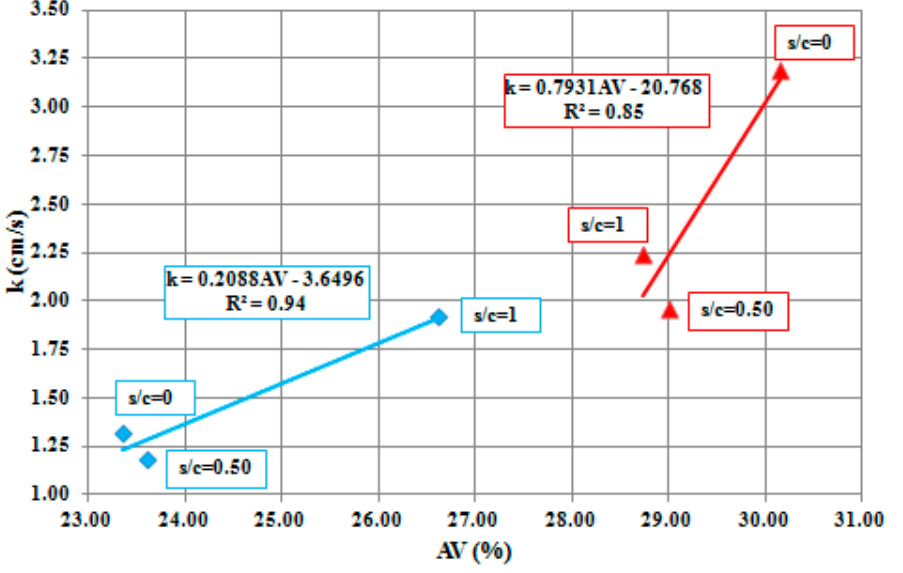
Figure 4. PCD and ACI 522R-10 methodologies linear regression and hydraulic model.